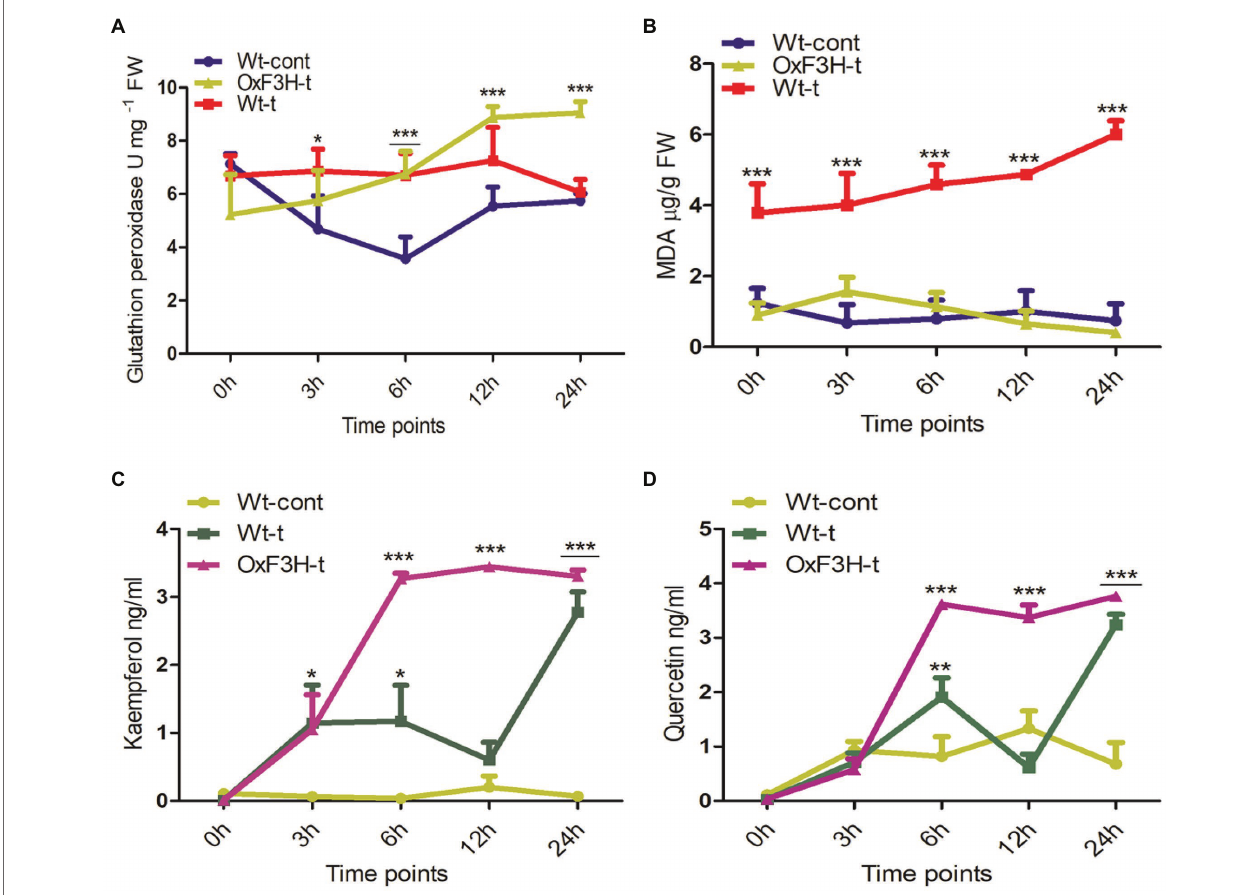
FIGURE 4 | Quantification of antioxidants and flavonoids in wild-type and transgenic plants in response to combined salt and heat stress. (A) Glutathione peroxidase, (B) lipid peroxidase (MDA), (C) kaempferol, and (D) quercetin accumulation in Wt-cont, Wt-t, and OxF3H-t plants after 0, 3, 6, 12, and 24 h of continuous exposure to stress conditions. Graphs show the mean ± standard deviation, and asterisks show significant differences (* p ≤ 0.05, ** p ≤ 0.01, and *** p ≤ 0.001) according to two-way ANOVA with Bonferroni post hoc